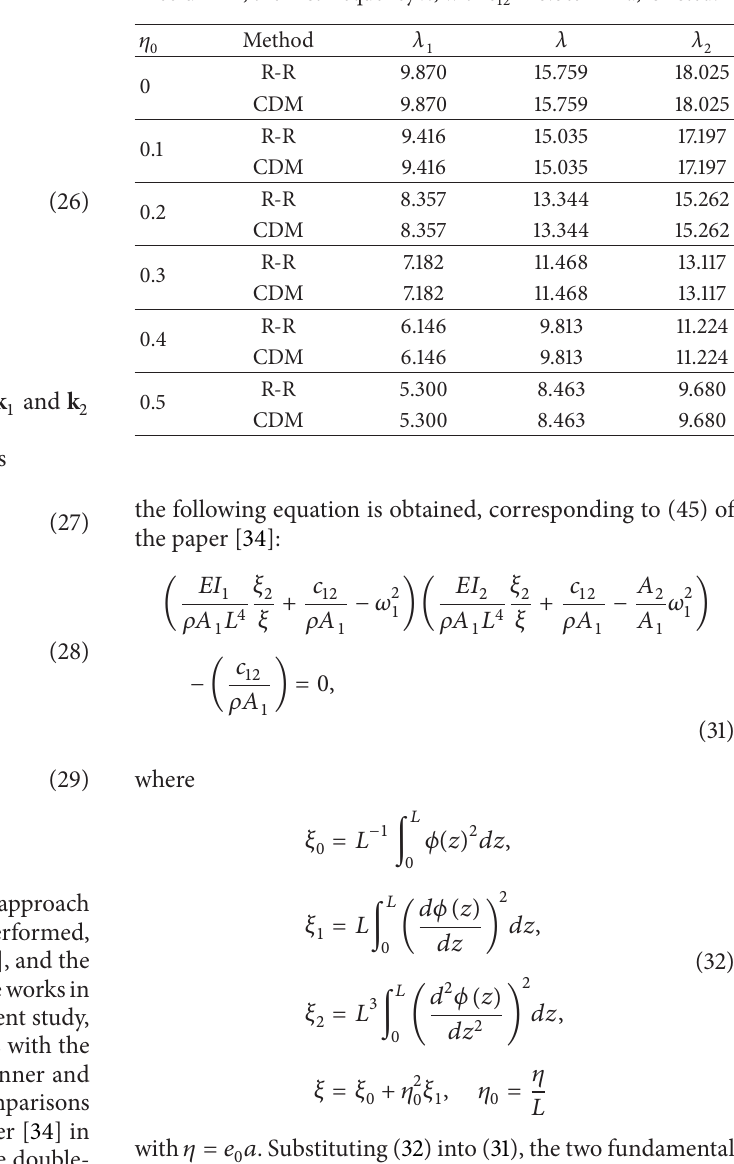
Table 1: Numerical comparison among R-R and CDM of simply supported DWCNTs: in columns 3 and 5 the first two dimensionless fundamental frequencies 𝜆 1 and 𝜆 2 , with 𝑐 12 = 0 , are reported, while in column 4, the first frequency 𝜆 , with 𝑐 12 = 0.0694 TPa, is